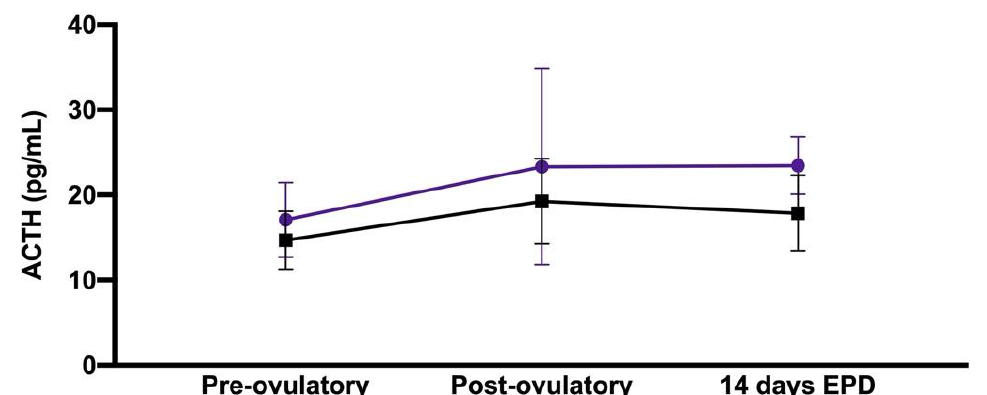
Figure 1. Mean ± standard deviation for immunoreactive plasma ACTH concentrations associated with early pregnancy and peri-ovulatory period, showing a significant effect of early pregnancy and time in the peri-ovulatory period upon the immunoreactive plasma ACTH concentration ( p = 0.04 and p = 0.04, respectively). Purple discs indicate pregnant mares (n = 11), and black squares indicate non-pregnant mares (n = 7). The x-axis does not reflect the time scale.